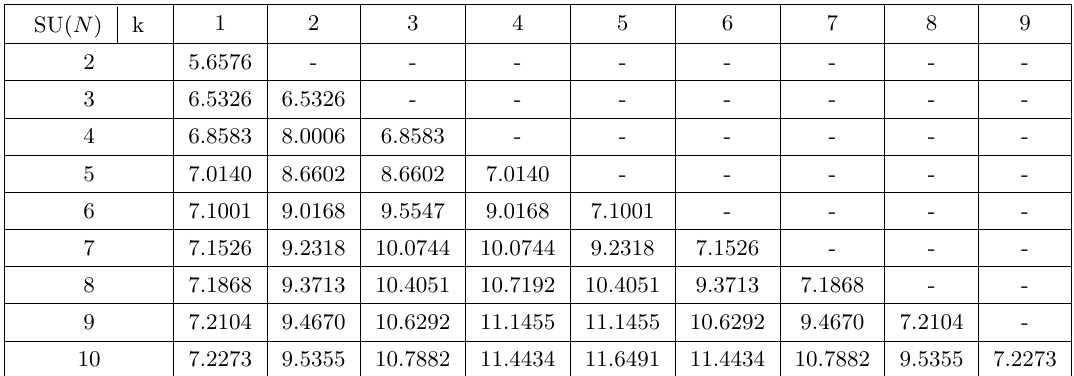
Table 1 . The numerical values, (3.4), of half k -string tensions for gauge groups ranging from SU(2) to SU(10). The upper bound estimate for error is 0 : 006. (cid:0) The total error estimate in minimizing (3.4) is given by: Total Error = Min. E. + Dis. E. + Trunc.